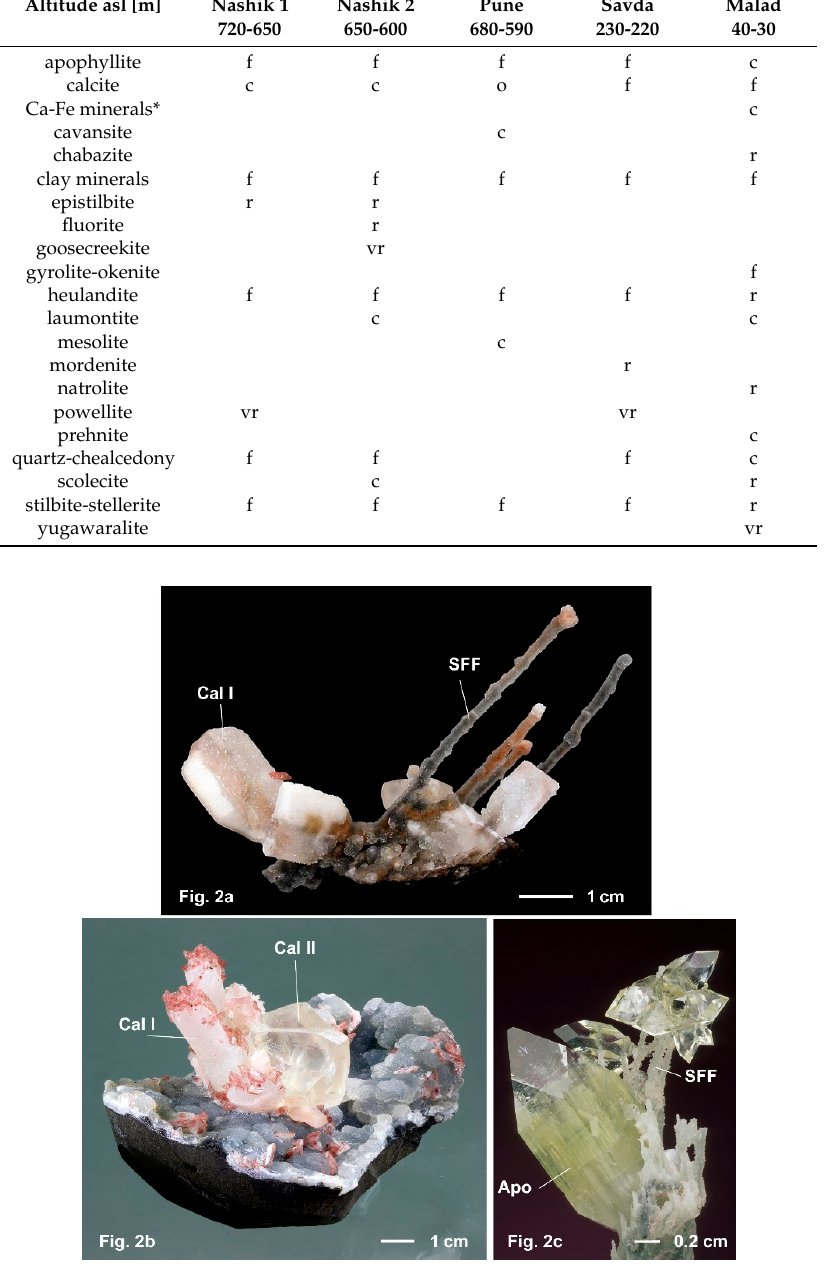
Figure 2. Hand specimens illustrating the precipitation sequence of secondary minerals from the DVP at Savda. ( a ) Twinned calcite I (Cal I) crystals and subsurface filamentous fabrics (SFFs) overgrown by chalcedony (© Superb Minerals Pvt. Ltd, Nashik, India). ( b ) Twinned calcite I (Cal I) crystals on basalt overgrown by chalcedony and later on by yellowish calcite II (Cal II) crystals and red heulandite. ( c ) Double ‐ terminated apophyllite crystals on chalcedony subsurface filamentous fabrics (SFFs) (© J. Scovil, Phoenix, AZ, United States).